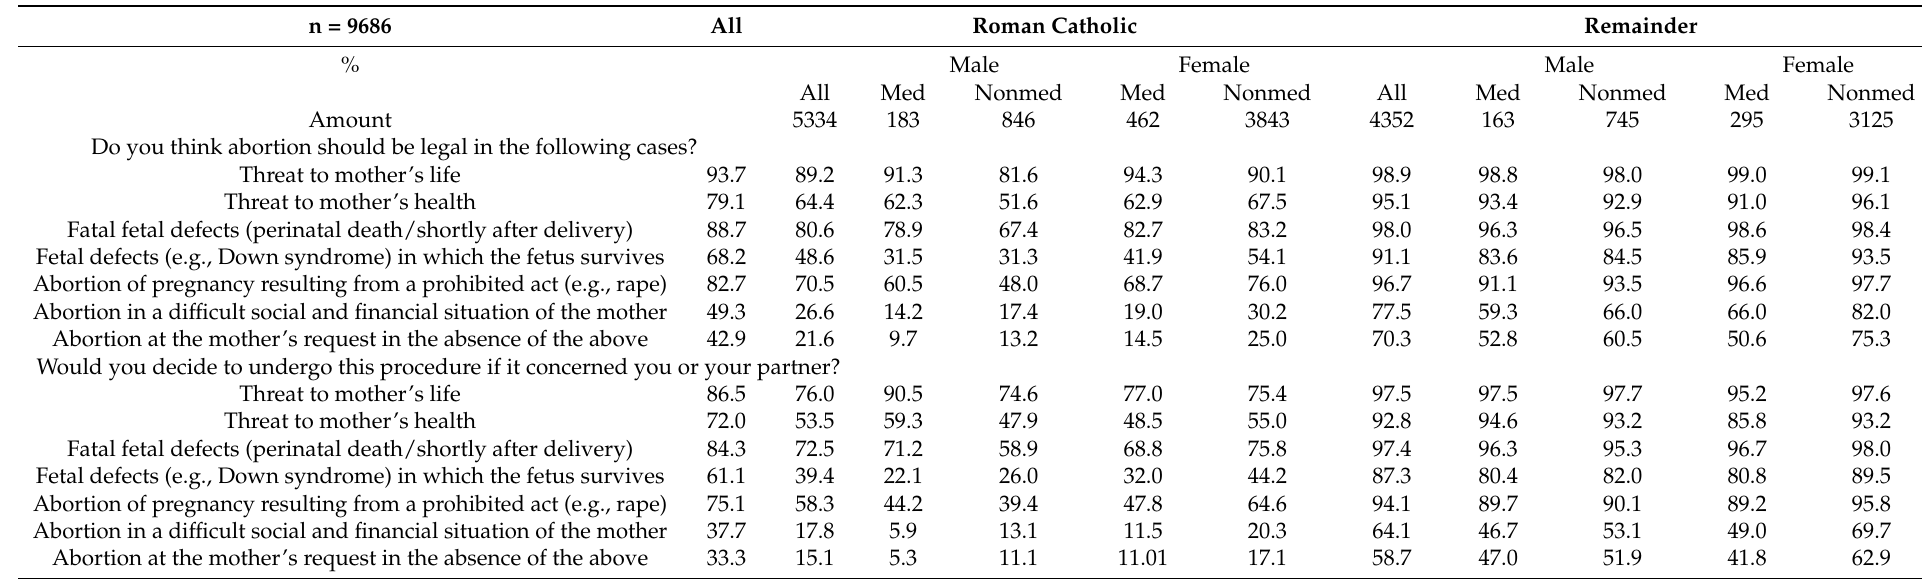
Table 4. Attitude to abortion regarding religion and gender. All data contained in table are presented as percentage [%] of answers YES for each question. n = 9686